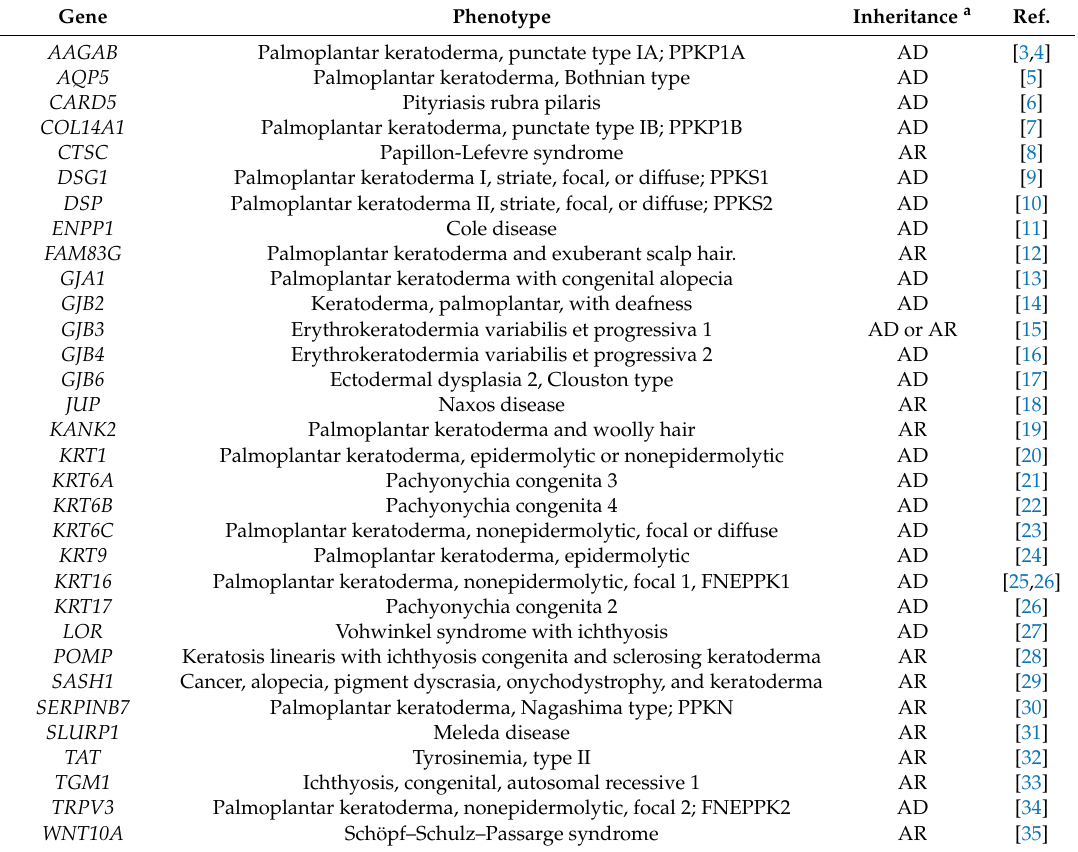
Table 1. Overview of genetic causes of human palmoplantar keratodermas